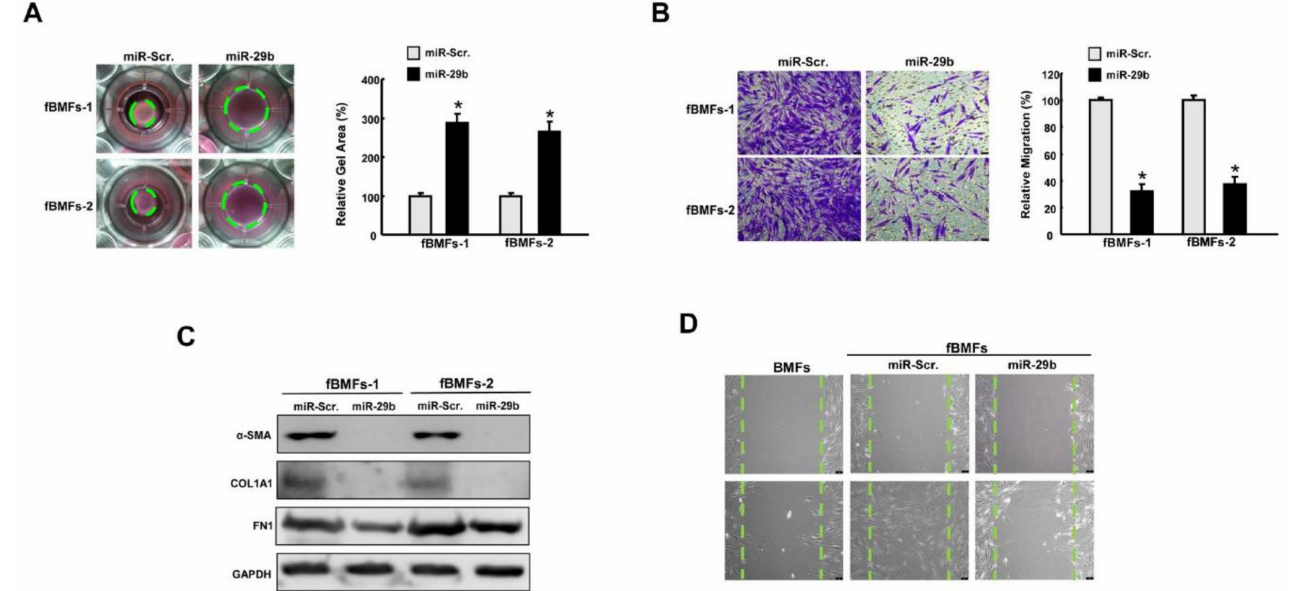
Figure 4. Overexpression of miR - 29b mitigates the features of myofibroblasts. ( A ) Collagen gel contraction and ( B ) migration ability of fBMFs with miR-Scr or miR - 29b mimics. Magnification, 100 × ( C ) Relative expression of SMA, type I collagen, and fibronectin (FN1) in fBMFs with miR-Scr or miR - 29b mimics. ( D ) Wound healing capacity of BMFs, fBMFs with miR-Scr, or fBMFs with miR - 29b mimics. Magnification, 100 × , * p < 0.05 compared to miR-Scr.